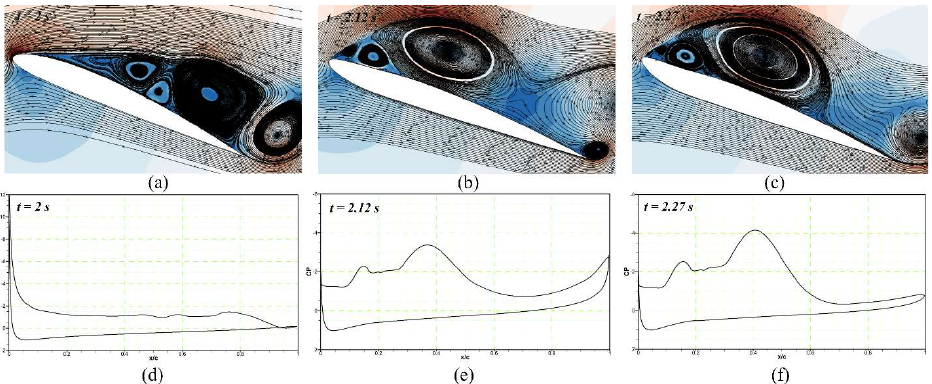
Figure 23. The upward deflection of the DMLE airfoil shows the ( a ) velocity streamline contours at time step of 2 s, ( b ) velocity streamline contours at time step of 2.12 s, ( c ) velocity streamline con-tours at time step of 2.27 s, ( d ) pressure coefficient at time step of 2 s, ( e ) pressure coefficient at time step 2.12 s and ( f ) pressure coefficient at time step of 2.27 s. These figures reveal the velocity stream lines with their respective pressure coefficients at different morphing leading edge de-flections and how the flow stability increases by minimizing the flow separation over an airfoil.